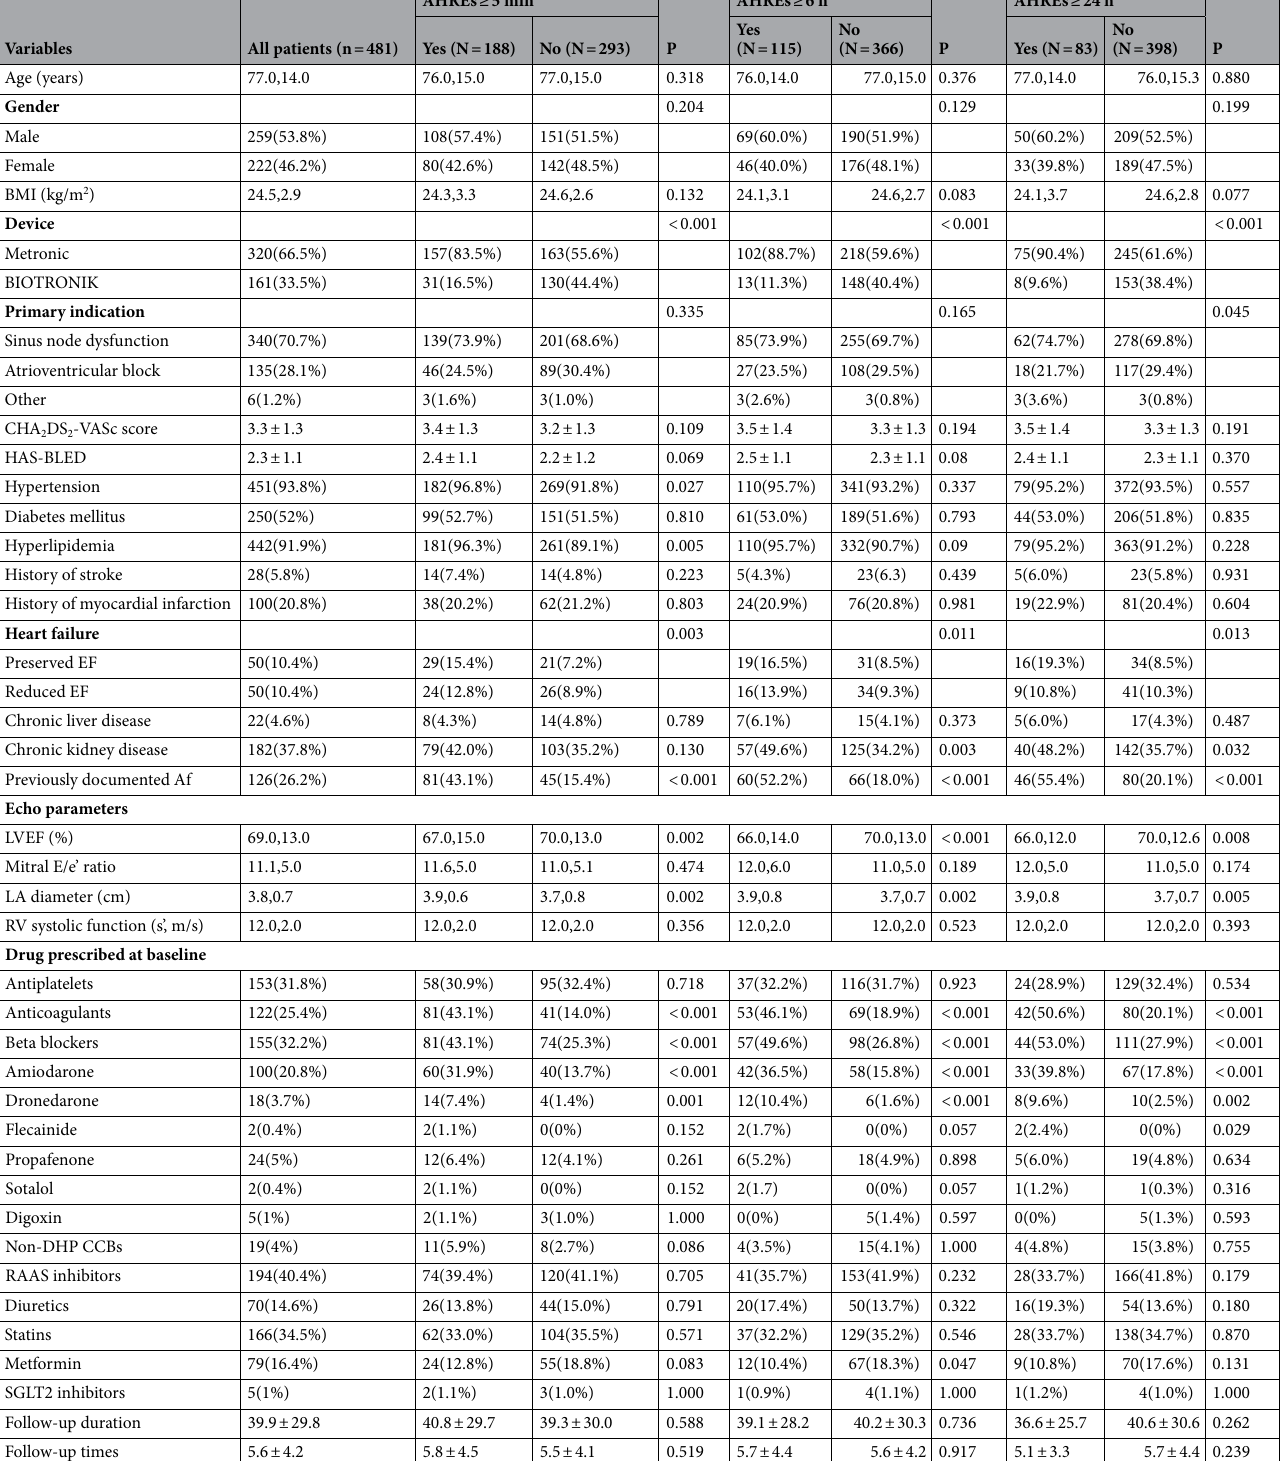
Table 1. Baseline characteristics of the overall study group. Data are presented as mean ± SD or median, IQR or n (%). AF atrial fibrillation, AHRE atrial high-rate episodes, BMI body mass index, EF ejection fraction, IQR interquartile range, LA left atrium, LVEF left ventricular ejection fraction, RV right ventricle, non-DHP CCBs non-dihydropyridine calcium channel blockers, RAAS renin–angiotensin–aldosterone system, SGLT2 sodium glucose co-transporters